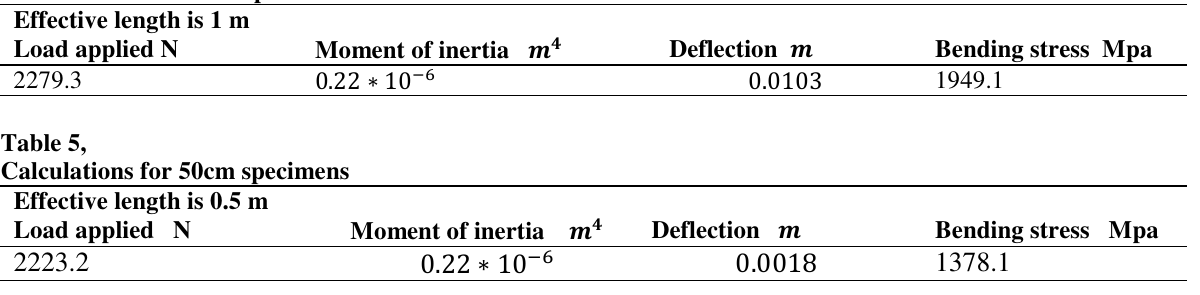
Calculation for 100cm specimens. Effective length is 1 m Load applied N